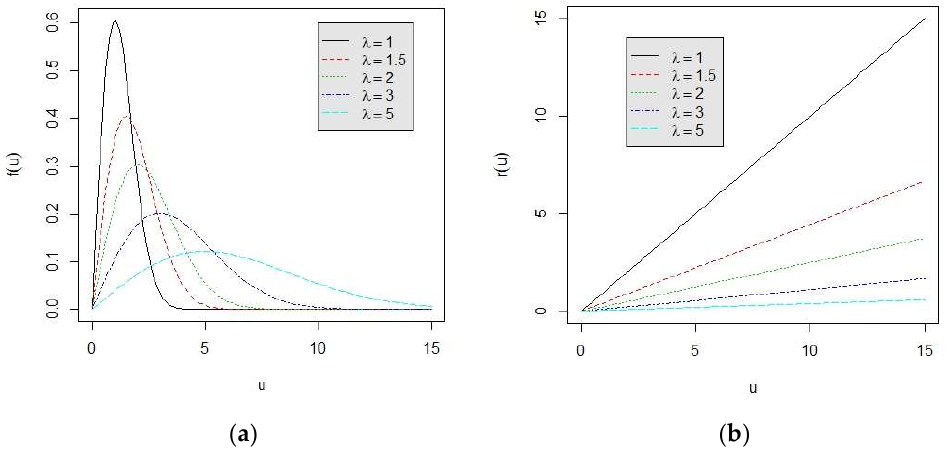
Figure 1. (a ) The curve of pdf for Rayleigh distribution; ( b ) the curve of failure rate function for Rayleigh distribution.